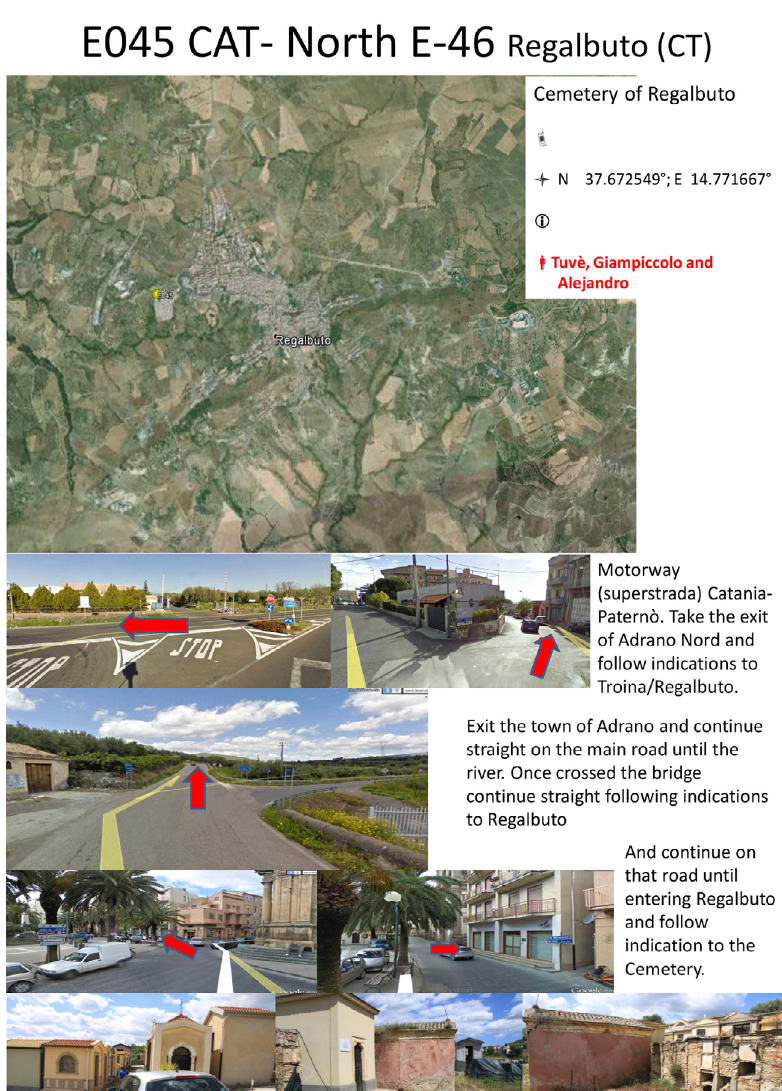
Figure 13. Information slides of one site selected for station location. In this case it is the Cemetery of Regalbuto town. From all potential locations described in the book, we se- lected the best 100 places following the criteria described in Section 4.1 and geometrical constraints to obtain a dense regular grid for the seismic